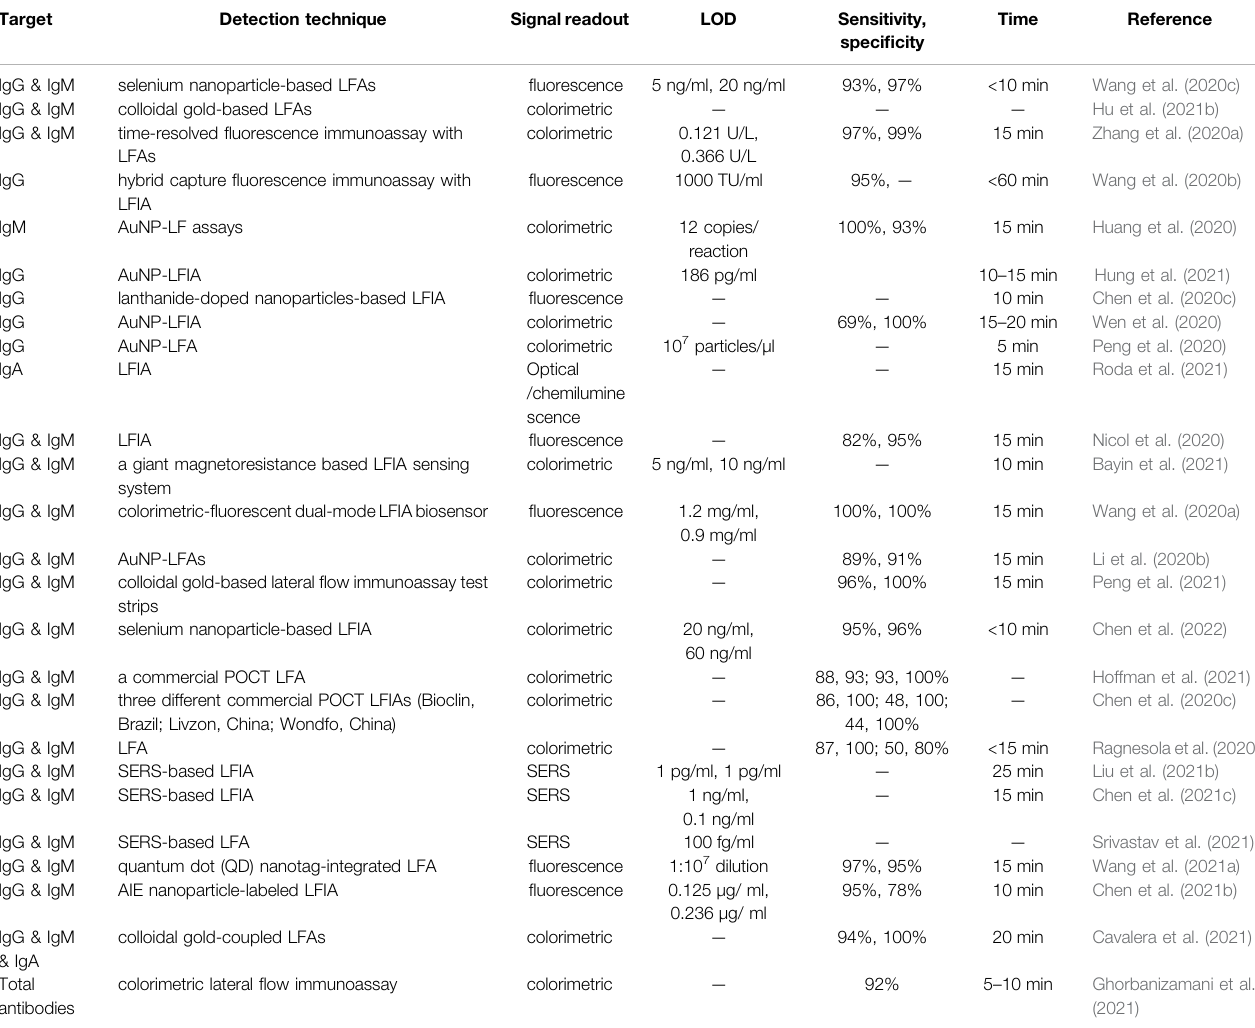
TABLE 2 | Antibody-targeting SARS-CoV-2 detection on the basis of lateral fl ow